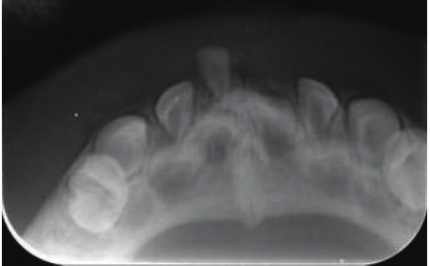
Figure 5: Radiographic aspect of thepatient at one year of follow-up showing that the natal teeth were regular primary